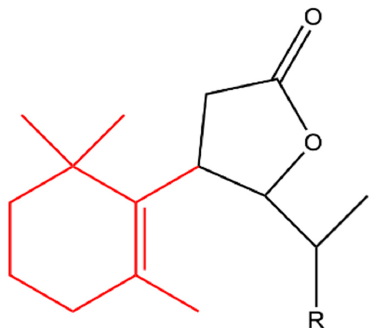
Figure 12. ( E )-2-(Methylthio)-4-(2-(2,6,6-trimethylcyclohex-2-en-1-yl)vinyl)pyrimidine. The α -ionone moiety is shown in blue.